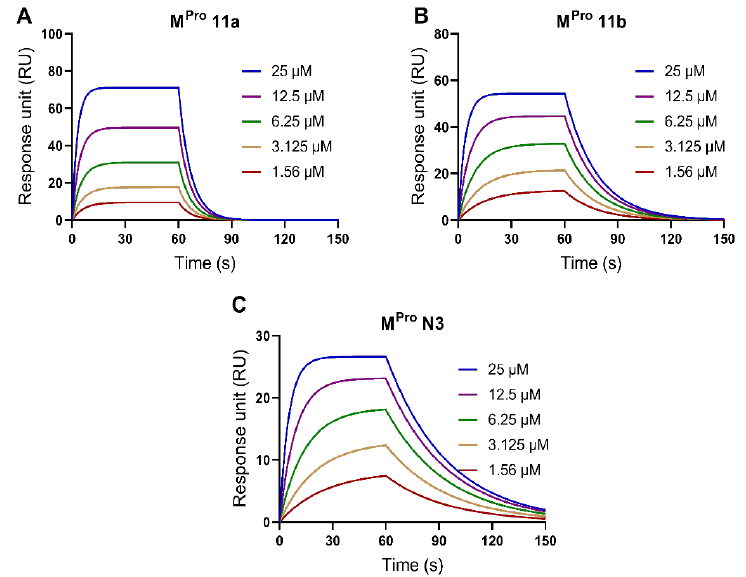
Figure 6. Validation of the SPR method to measure the binding affinities between the M pro protein and several known SARS-CoV-2 M pro inhibitors including M pro 11a ( A ), M pro 11b ( B ), and M pro N3 ( C ). Table 1. M pro protein binding parameters ( K a, K d, and K D ) of known SARS-CoV-2 M pro inhibitors obtained from the SPR experiments.